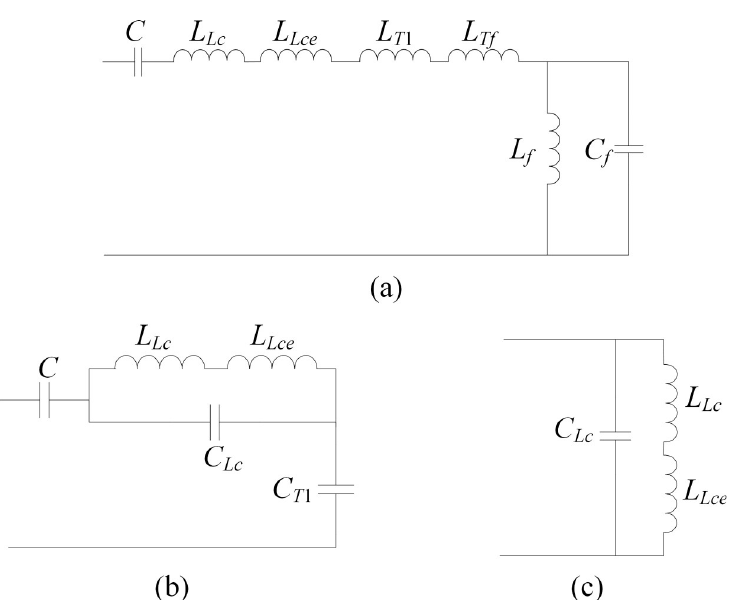
Fig 4. Resonant circuits of the CVT with a speedy saturation damper. (a) Resonant circuit 1. (b) Resonant circuit 2. (c) Resonant circuit 3.